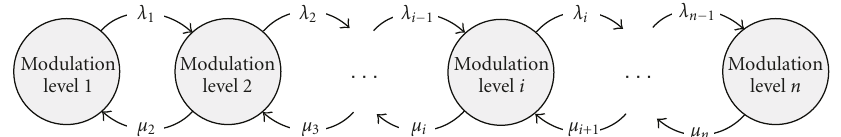
Figure 5: The queueing system with the state of modulation